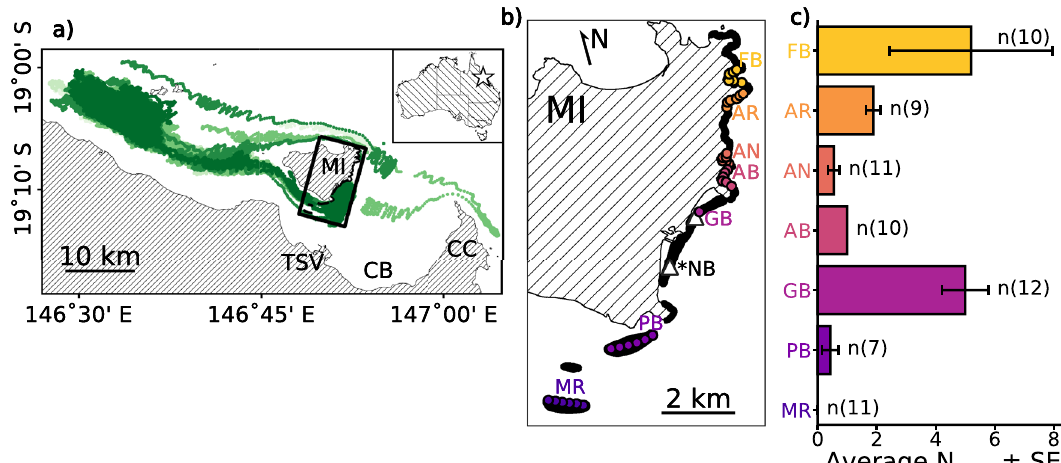
Figure 1. The Copula sivickisi population at Magnetic Island (MI) in the Townsville (TSV) region (star), Queensland, Australia. ( a ) Population structure analysis (green colour scale). The simulated export of C. sivickisi from MI, i.e., the tracks of the C. sivickisi medusae lost from MI reefs as adults during the 2017 season (< 0.1% of seeded medusae). The different colours distinguish the results of the five replicate model runs. CB cleveland bay, CC cape cleveland. The rectangle over MI shows the extent of pane ( b ). ( b ) Population mapping (yellow to purple colour scale). The JCam survey design covering Middle Reef (MR), Picnic Bay (PB), Geoffrey Bay (GB), Alma Bay (AB), Alma North (AN), Arthur Bay (AR) and Florence Bay (FB). The dots show where the JCams were deployed, and are colored by location. The white triangles show the sites in Nelly Bay (NB; * no JCams were deployed in NB) and GB where the modelled currents were extracted for Fig. 2. Land is filled with a hatch pattern and reefs are shown in black. ( c ) The abundance (average N max from JCams) of C. sivickisi medusae at each of the colorcoded locations. The number of sites averaged per location are indicated; total n =